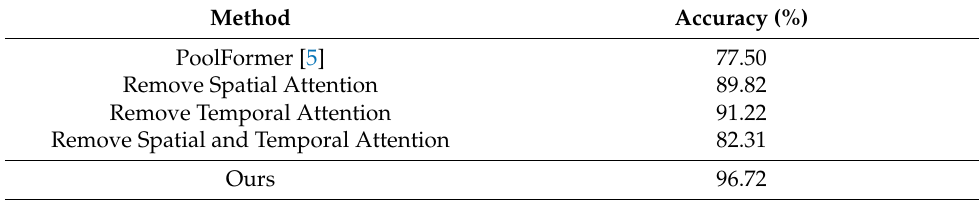
Table 6. Ablation results of spatial attention and temporal